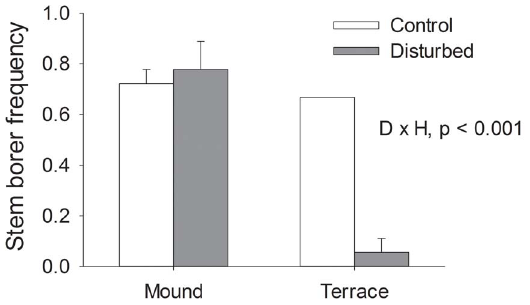
Figure 4. Disturbance and patch size effects on stem borers. Effects of disturbance treatments in large (terraces) and small (mounds) patches on stem borer frequency. Error bars represent standard error. Significant treatment effects from two-way ANOVA are noted; D=Disturbance, H=Habitat patch size.